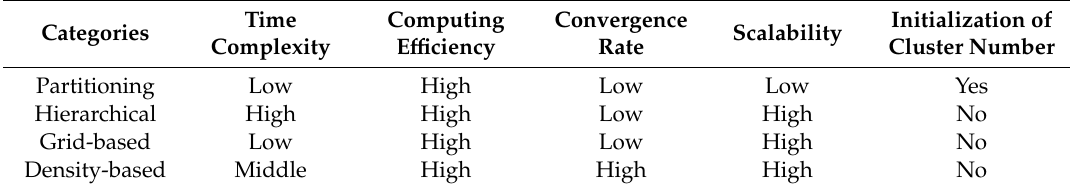
Table 1. Di ff erences among categories of clustering techniques.